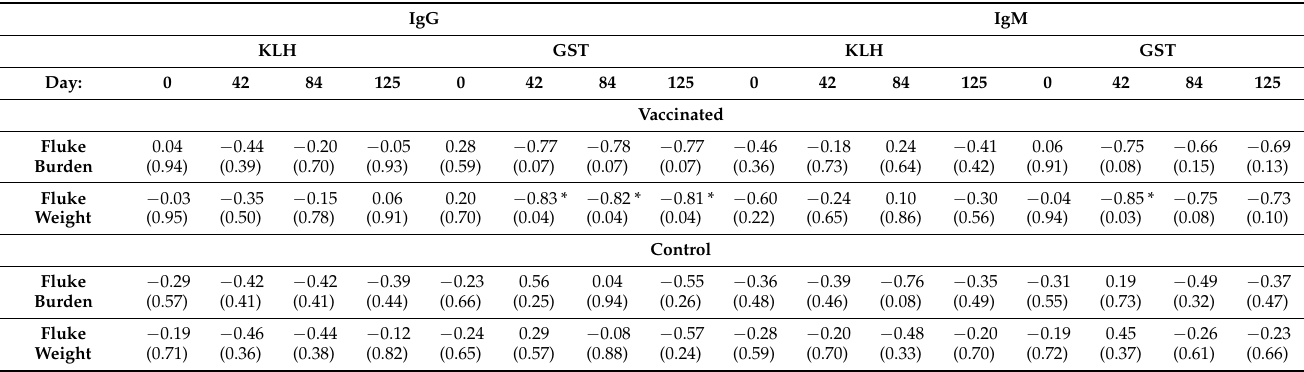
Table 1. Pearson’s correlation coefficients ( p -values in parentheses) for the bovine IgG and IgM humoral responses and the liver fluke burdens and wet weights for animals in the vaccinated ( n = 6) and control ( n = 6) group of study A. The natural antibody response is assessed to KLH and the specific antibody response to native glutathione S -transferase (GST). Significant values ( p < 0.05) are noted with an asterisk